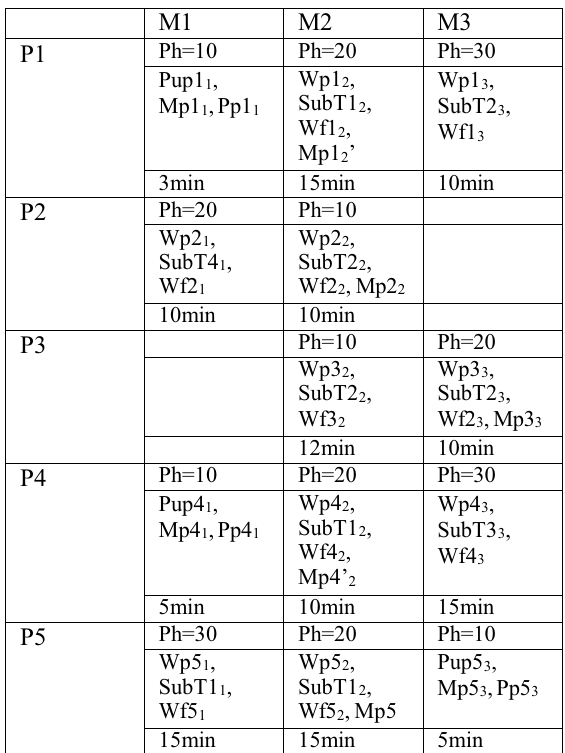
Table 1: Tasks and machine orders for 5 products